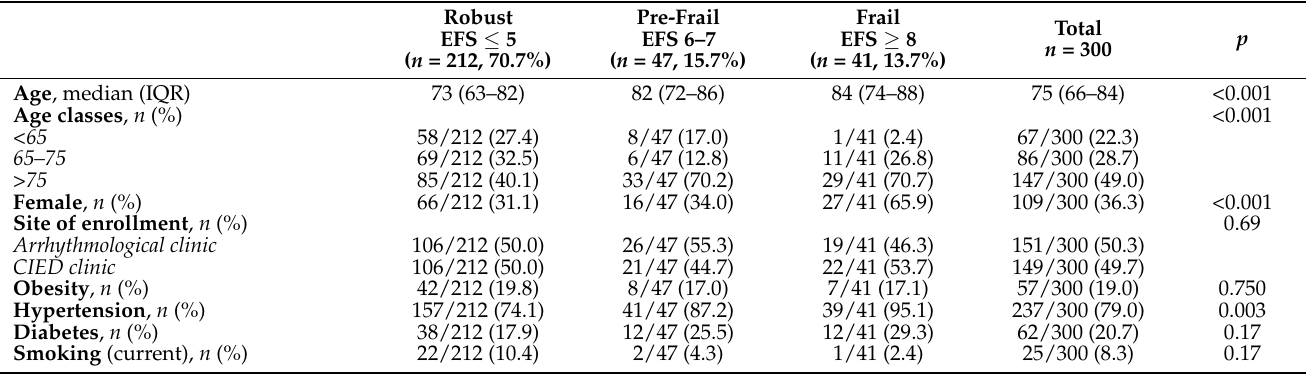
Table 1. Baseline characteristics of the population stratified for frailty status according to the Edmon- ton Frail